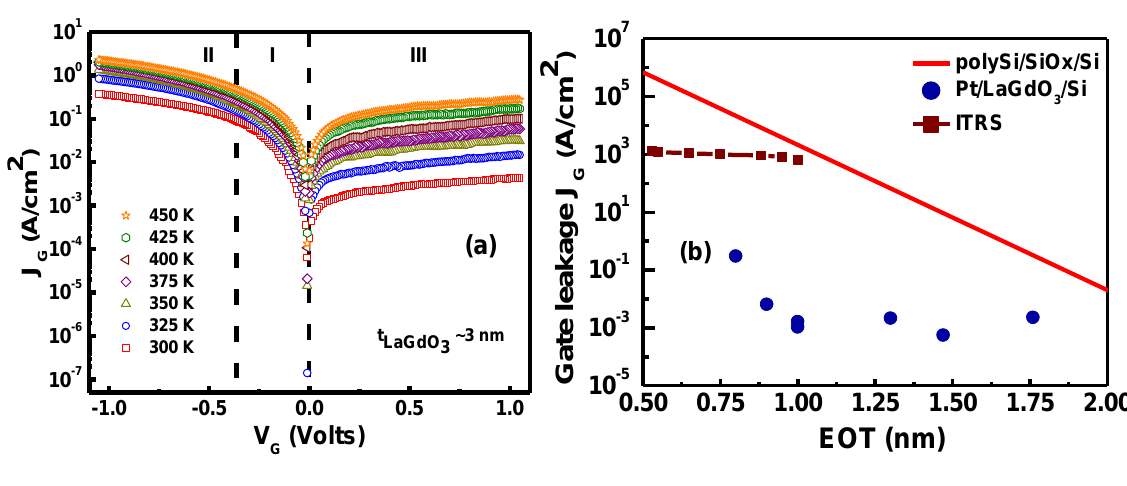
Figure 16. ( a ) The temperature-dependent leakage current density ( J ) versus the gate G voltage ( V ) characteristics of a Pt/LaGdO /Si(100) n-MOS device; ( b ) comparison of the G 3 leakage current densities of various LaGdO ultra-thin gate stacks with EOT ≤ 1.8 nm 3 (without quantum corrections) with International Technology Roadmap for Semiconductors (ITRS) requirements and thermal SiO films. Reprinted with permission from 2